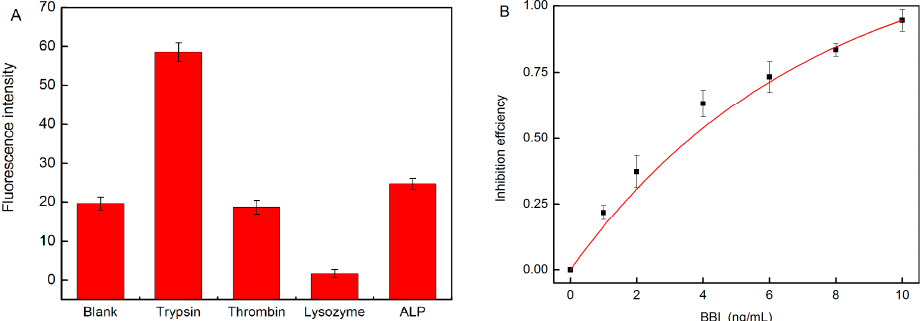
Figure 4. Selectivity test for trypsin ( A ). The concentrations of trypsin, alkaline phosphatase (ALP), lysozyme, thrombin are 20.0 ng/mL, 20.0 U/mL, 2.0 μ g/mL, and 8.0 μ g/mL, respectively. Inhibitory efficiency of BBI on the activity of trypsin ( B ). The concentration of trypsin is 20 ng/mL.